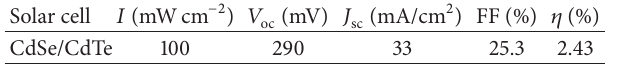
Table 4: Photovoltaic parameters for the CdSe/CdTe thin film solar cell under 100mWcm − 2 illumination